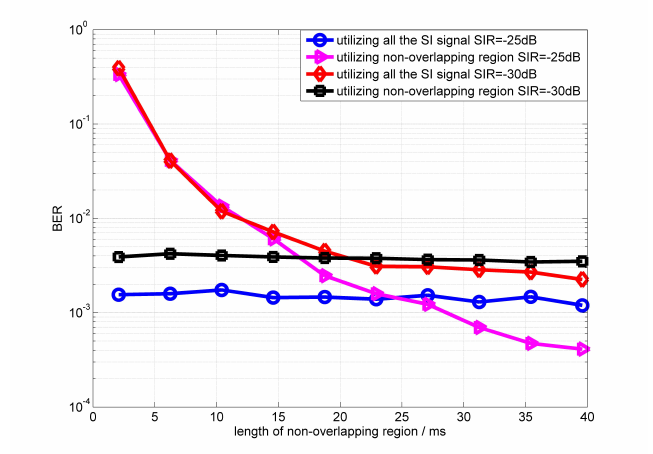
Figure 9. BER performance of OPRLS utilizing the non-overlapping region versus the length of the non-overlapping region.